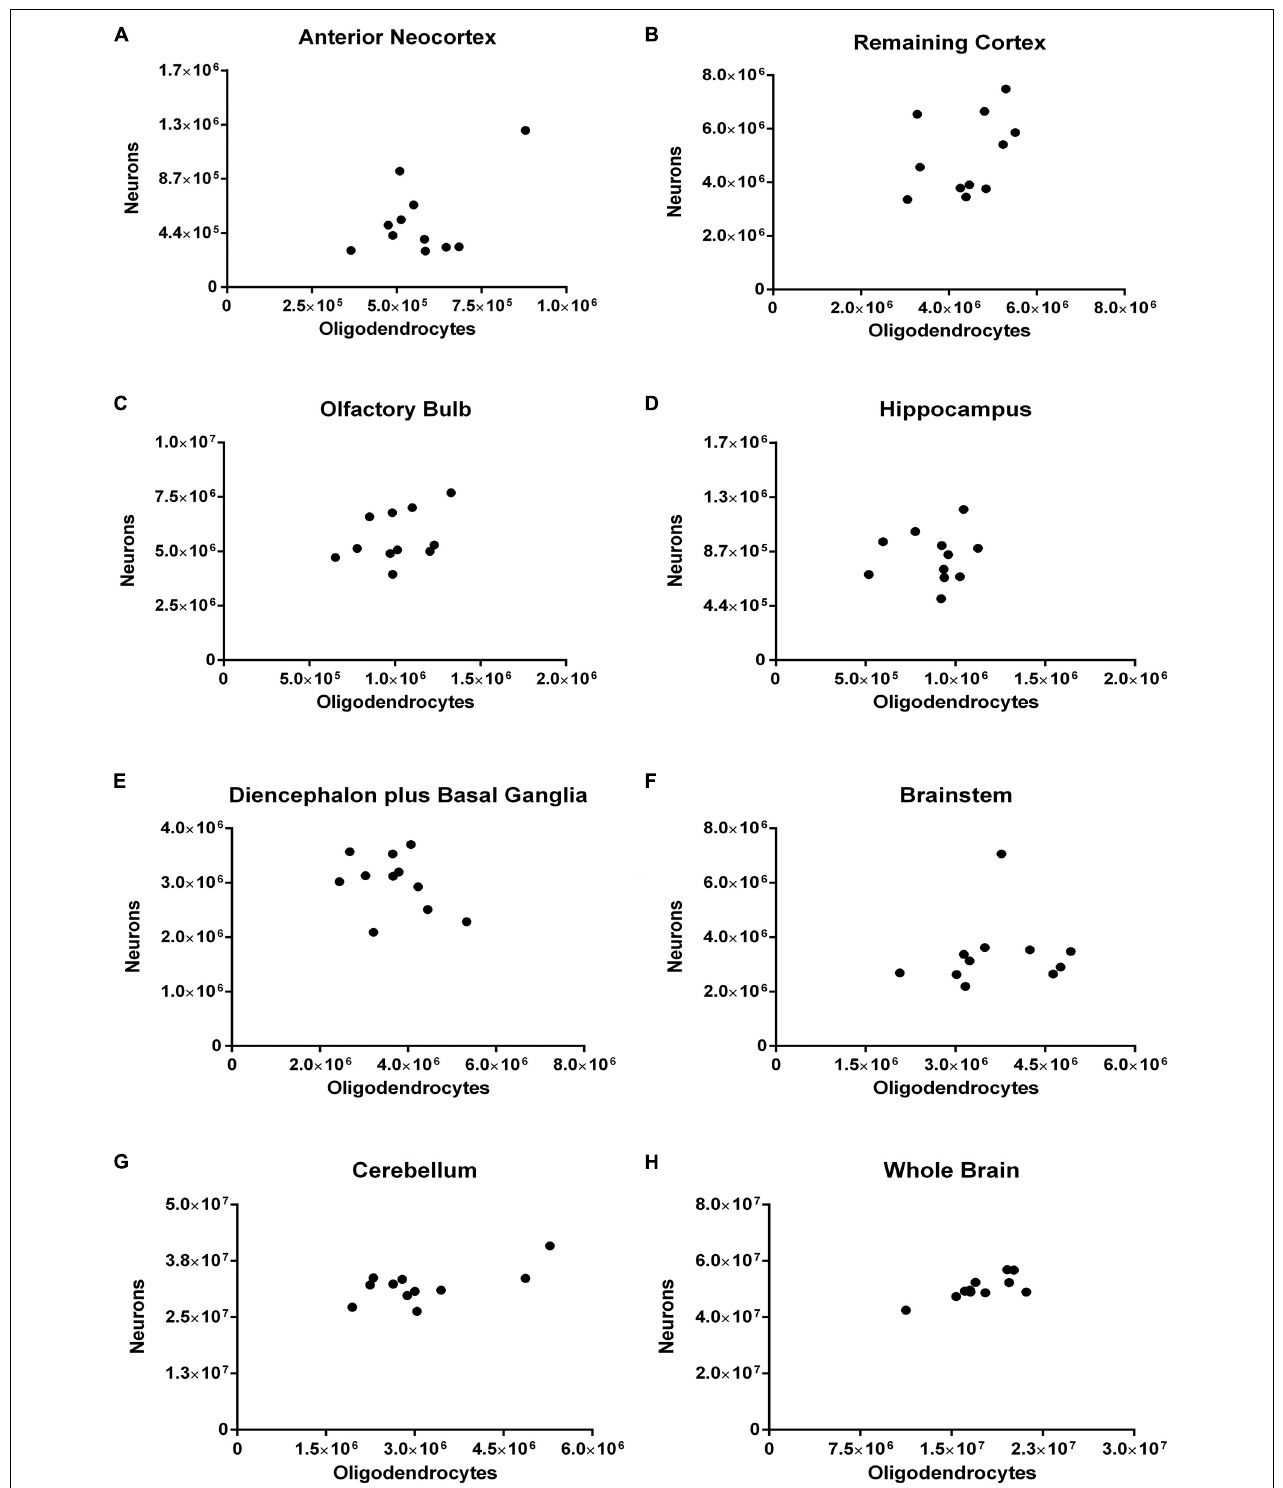
FIGURE 9 | Spearman’s correlation between the absolute numbers of neurons and of oligodendrocytes. Dissected regions are shown from (A–G) . The data for the whole brain is displayed in (H) . (A) Anterior Neocortex: rho = 0.0272, p = 0.9462. (B) Remaining Cortex: rho = 0.4727, p = 0.1457. (C) Olfactory Bulb: rho = 0.4273, p = 0.1928. (D) Hippocampus: rho = 0.0545, p = 0.8812. (E) Diencephalon plus Basal Ganglia: rho = –0.3000, p = 0.3713. (F) Brainstem: rho = 0.3727, p = 0.2608. (G) Cerebellum: rho = 0.2364, p = 0.4854. (H) Whole Brain: rho = 0.5909, p = 0.0609. Each dot represents one animal ( n = 11).